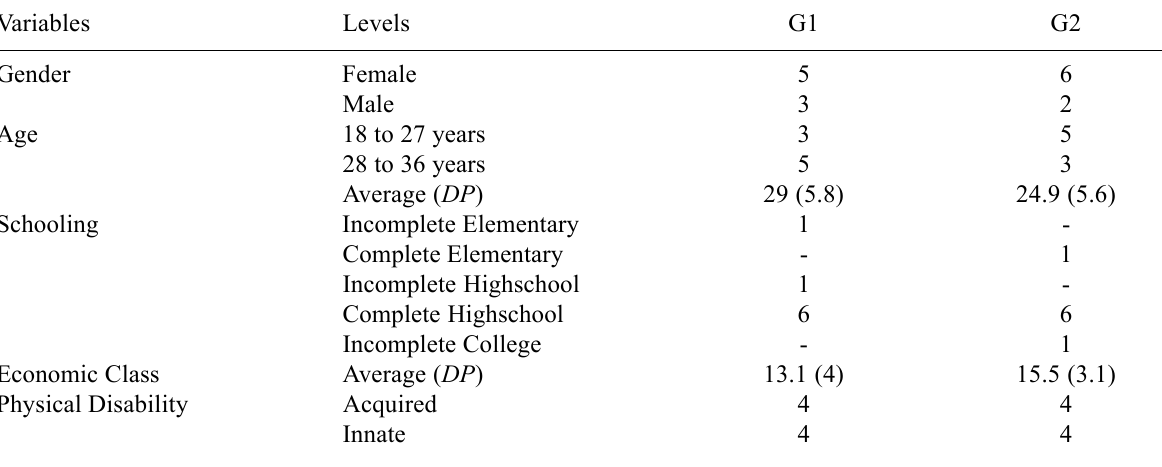
Table 1 Characteristics of the Sample, According to the Composition of Groups G1 (n=8) and G2 (n=8)